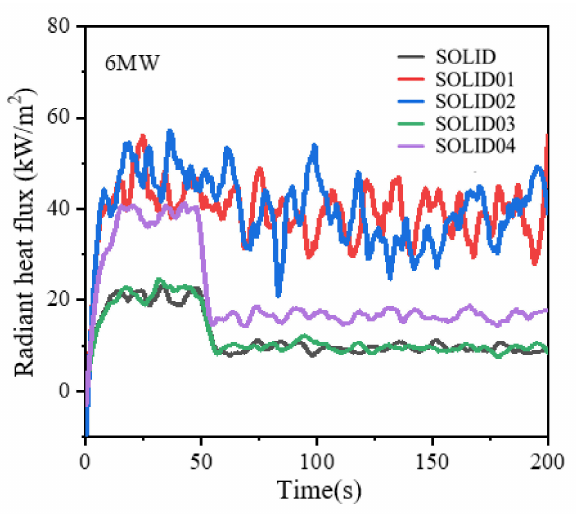
Figure 29. Variation of radiant heat flux of glass under window sprinkler conditions. The convective heat flux simulated by the 6 MW window sprinkler is shown in Figure 30. The convective heat fluxes in the lower left and right are essentially zero throughout the simulation, because the temperature difference between the underside of the glass and the environmental temperature is small, and there is essentially no convective heat transfer between the two. The convective heat fluxes in the center, upper left and upper right first increased and then decreased during 0–200 s, because before the sprinkler was not started, due to the progress of the combustion reaction, the temperature difference between the temperature in the center, upper left and upper right of the glass and the environmental temperature gradually increased, so the convective heat flux shows an upward trend before 50 s. When the window sprinkler is activated at 50 s, the temperature in the middle of the glass is rapidly lowered so that the convective heat flux in the center decreases. The simulation results show that the window sprinkler can effectively reduce the convective heat transfer between the glass surface and the